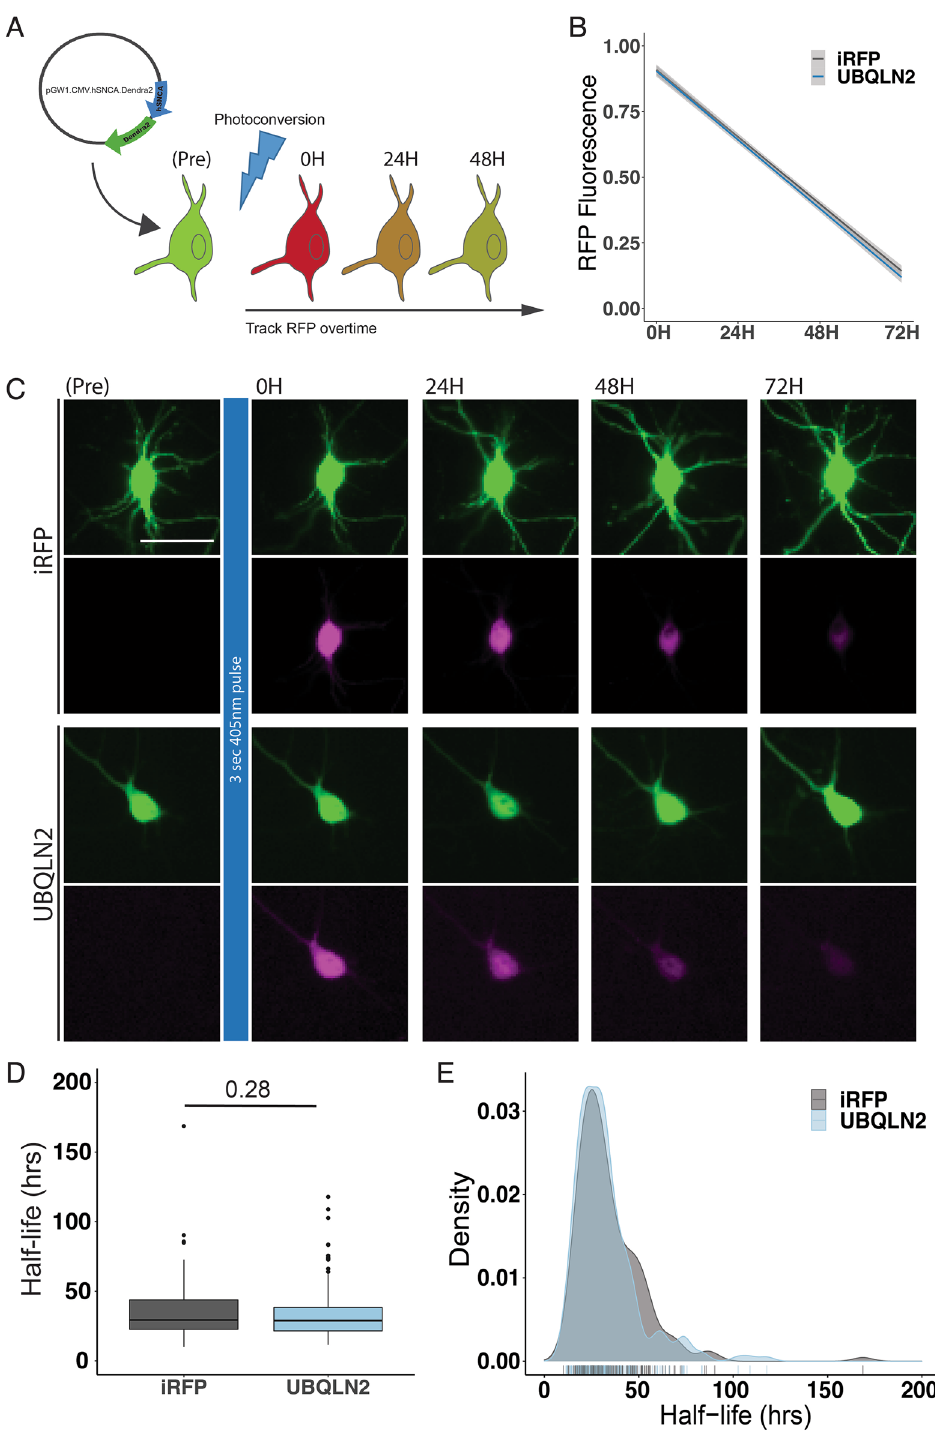
Figure 6. Optical Pulse Labeling reveals no effect of UBQLN2 on α-syn clearance in neurons. ( A ) Schematic of Optical Pulse labeling experiment. Rat primary cortical neurons were transfected with hSyn-Dendra2 and UBQLN2-iRFP or iRFP. Dendra2 was photoconverted 24 h post-transfection with 405 nm light, imaged immediately and every 24 h thereafter for 3 days. Scale bar 25 μm. ( B ) Optical pulse labeling reveals no change in red fluorescence intensity over time in neurons transfected with UBQLN2 (n = 213) compared to control (n = 182; p = 0.6). ( C ) Representative images of optical pulse labeling of hSyn-Dendra2 in rat primary cortical neurons transfected with hSyn-Dendra2 and UBQLN2-iRFP or iRFP. ( D ) Optical pulse labeling in primary rate neurons reveals no change in half-life of hSyn-Dendra2 upon transfection with UBQLN2 vs control (iRFP; p = 0.28). hSyn-Dendra2 half-life was determined by measuring the loss of photoconverted hSyn-Dendra2 (RFP) signal over time for each cell. ( E ) Density plot of hSyn-Dendra2 half-life measurements from individual neurons transfected with control (n = 182) or UBQLN2 (n = 213). Values were pooled from eight wells per condition, from each of two biological replicates and analyzed by the Kruskal–Wallis